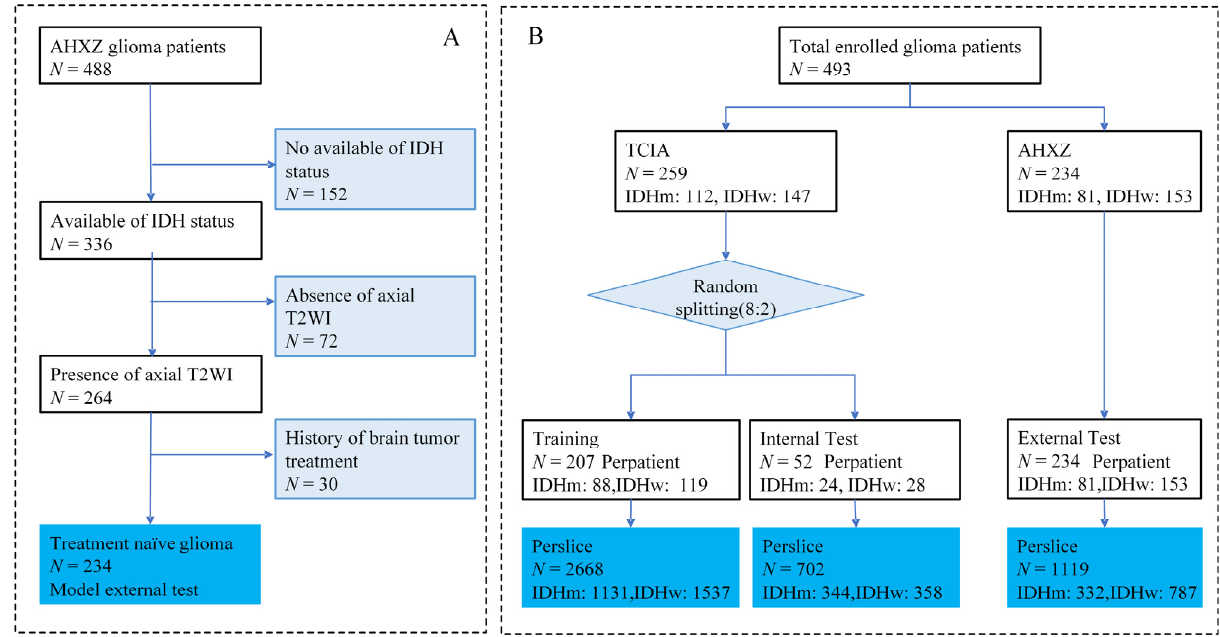
Figure 1. Flowchart of patient enrollment and network implementation. ( A ) Flow diagram of AHXZ dataset enrollment. ( B ) Patient information for model implementation. IDHm = IDH mutant type; IDHw = IDH wild type.